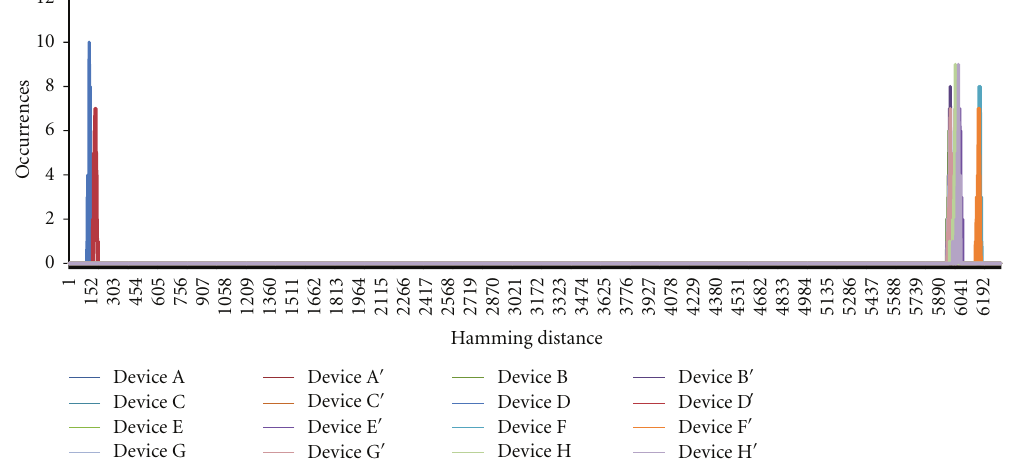
Figure 8: Distribution of Hamming distances of test set T D = ( τ 1